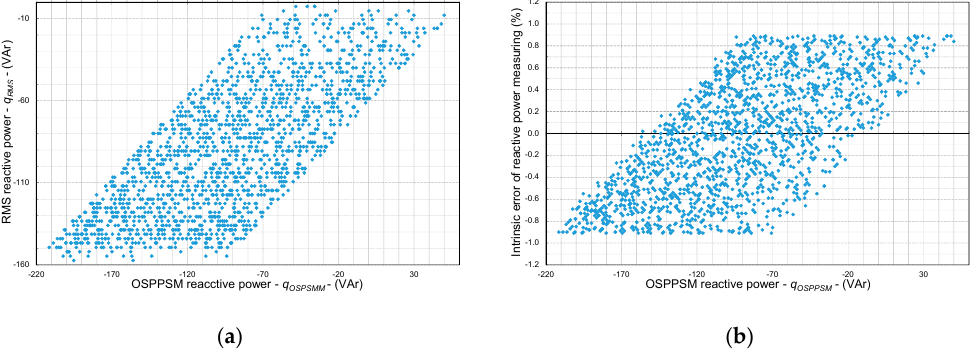
Figure 11. Wattmeter test: ( a ) OSPPSM vs. RMS active power. ( b ) Intrinsic error of active power measuring.